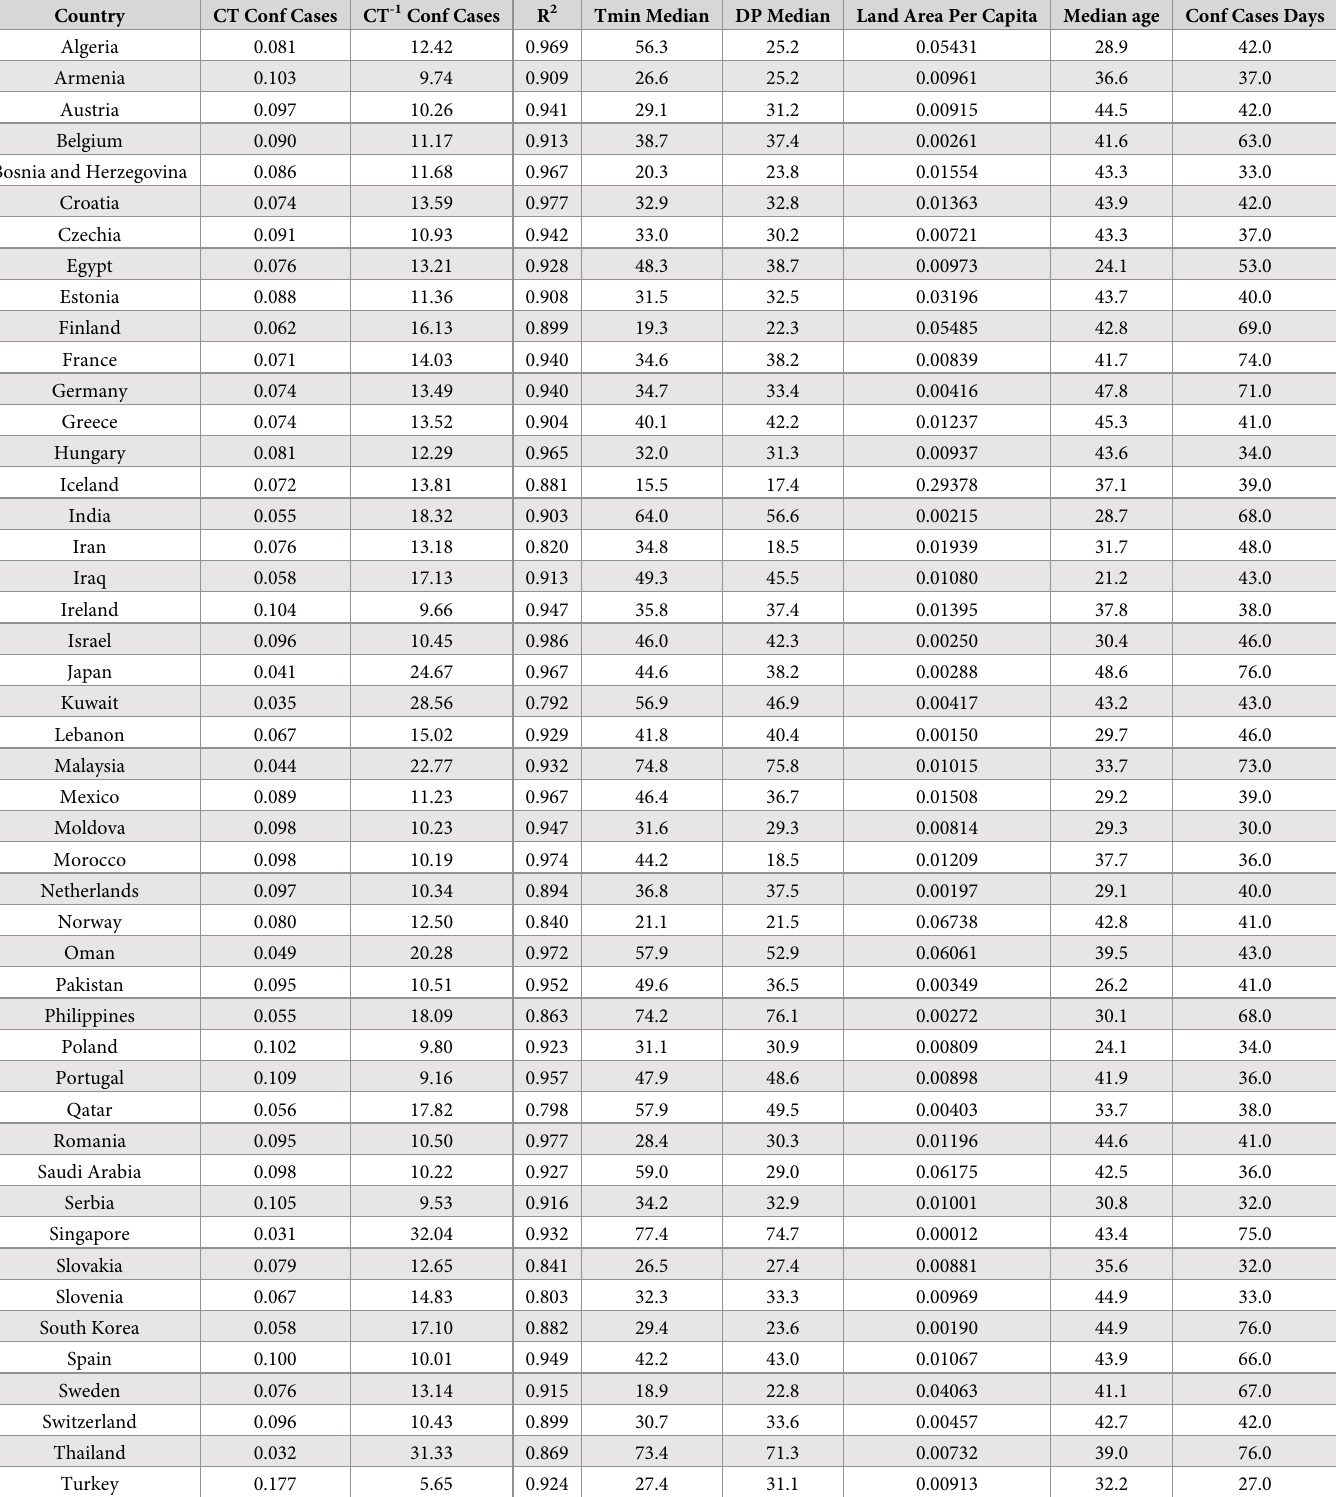
Table 1. First regression: Rate of rise of confirmed cases of COVID-19 in 50 countries, and the associated local meteorological and demographic variables.